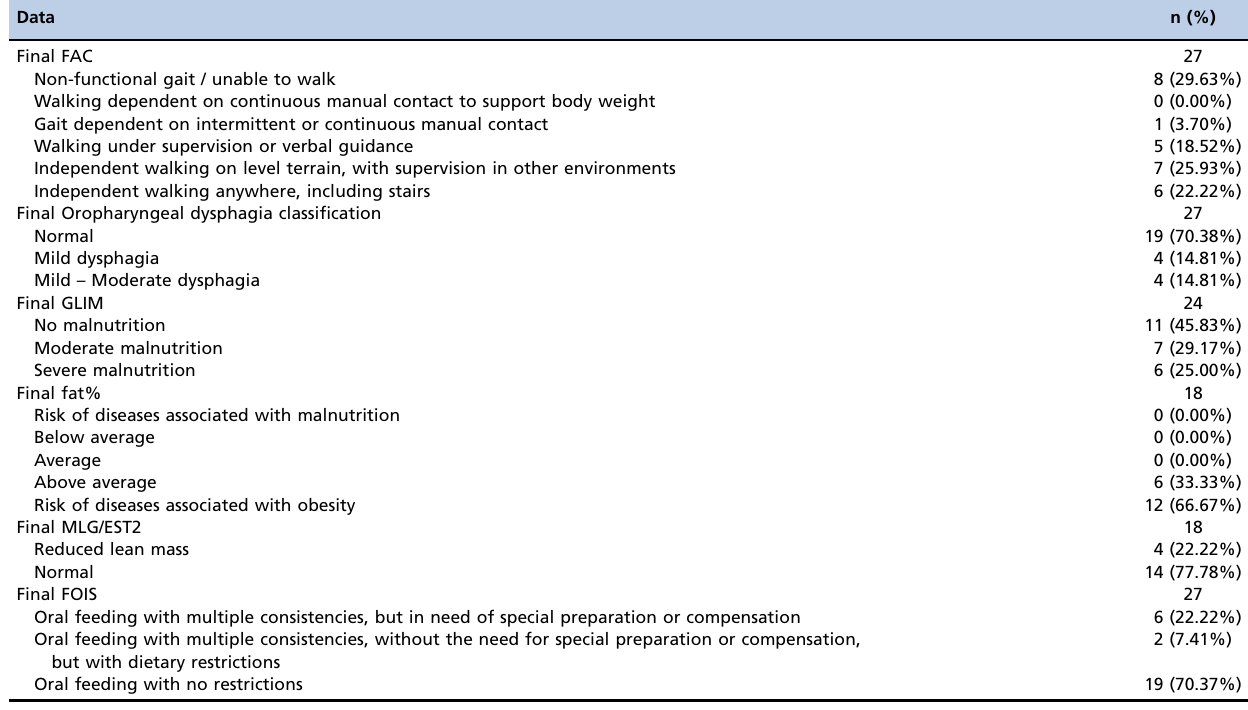
Table 4 - Categorical variables of the patients ’ characteristics at discharge from the inpatient rehabilitation treatment. Data n (%) Final FAC